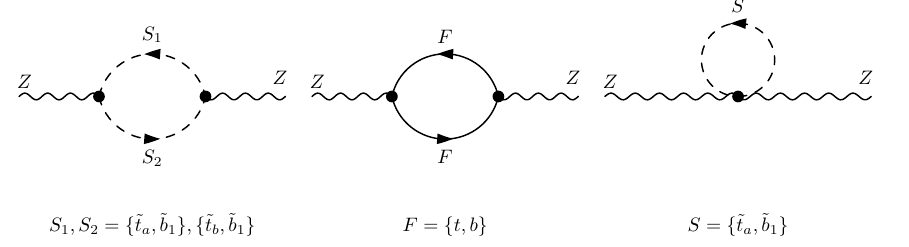
Figure 6 . Generic one-loop self-energies of the Z boson contributing at O ( (cid:11) t ) to the renormaliza- tion of v . A summation over the indices a; b = 1 ; 2 of the internal stops is implicit. Here, (cid:6) (1) ;T